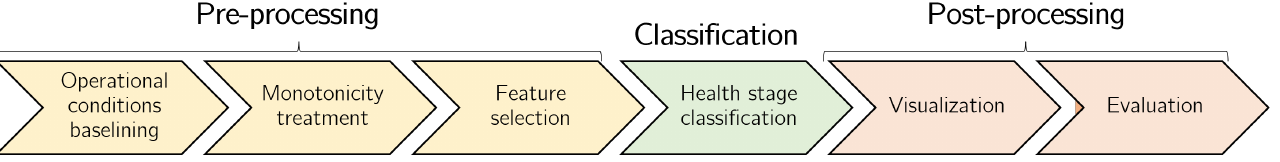
Figure 4. The prognostics flow is composed of a number of steps, including the steps of operational condition identification and aggregation, monotonicity treatment and noise removal, and feature se- lection, followed by the actual health stage identification. The flow is complete after the visualization and evaluation